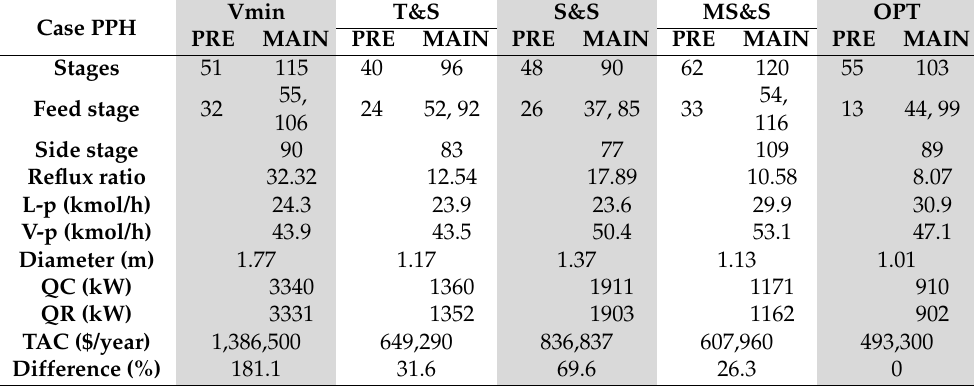
Table 6. Results for the i-pentane, n-pentane, and n-hexane (PPH)